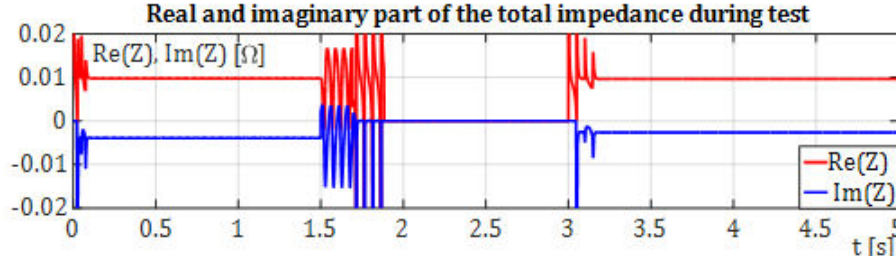
Figure 3. Results of the computer simulation for real and imaginary parts of motor